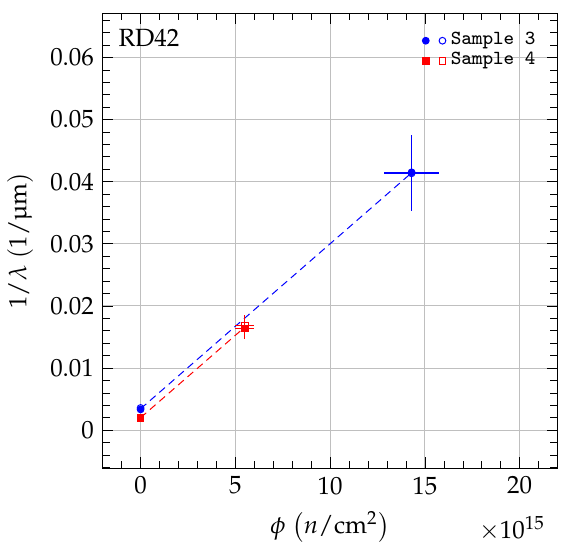
Figure 6. The 1/ λ for pCVD diamond in the fast neutron irradiation. The two values shown at each fluence are the values for positive (solid markers) and negative (open markers) bias at E = The data were fit with a first-order damage curve independently for each sample.